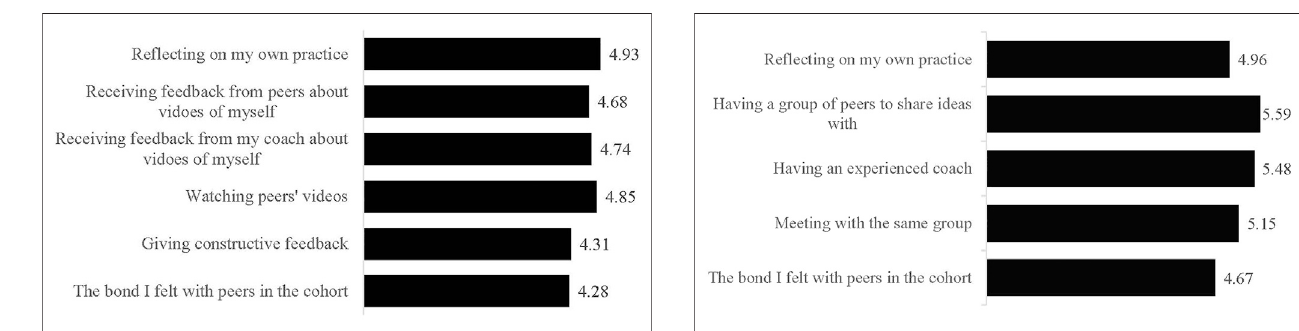
FIGURE 4 | Essentials elements ratings, provided by purposeful questions educators.